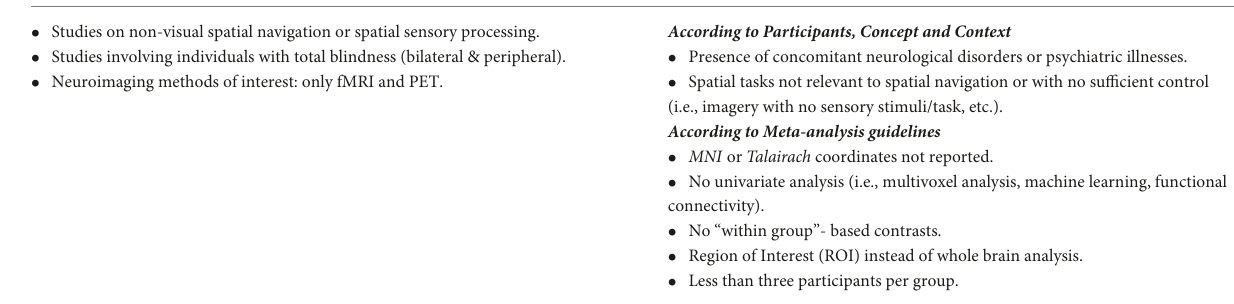
TABLE 1 Inclusion and exclusion